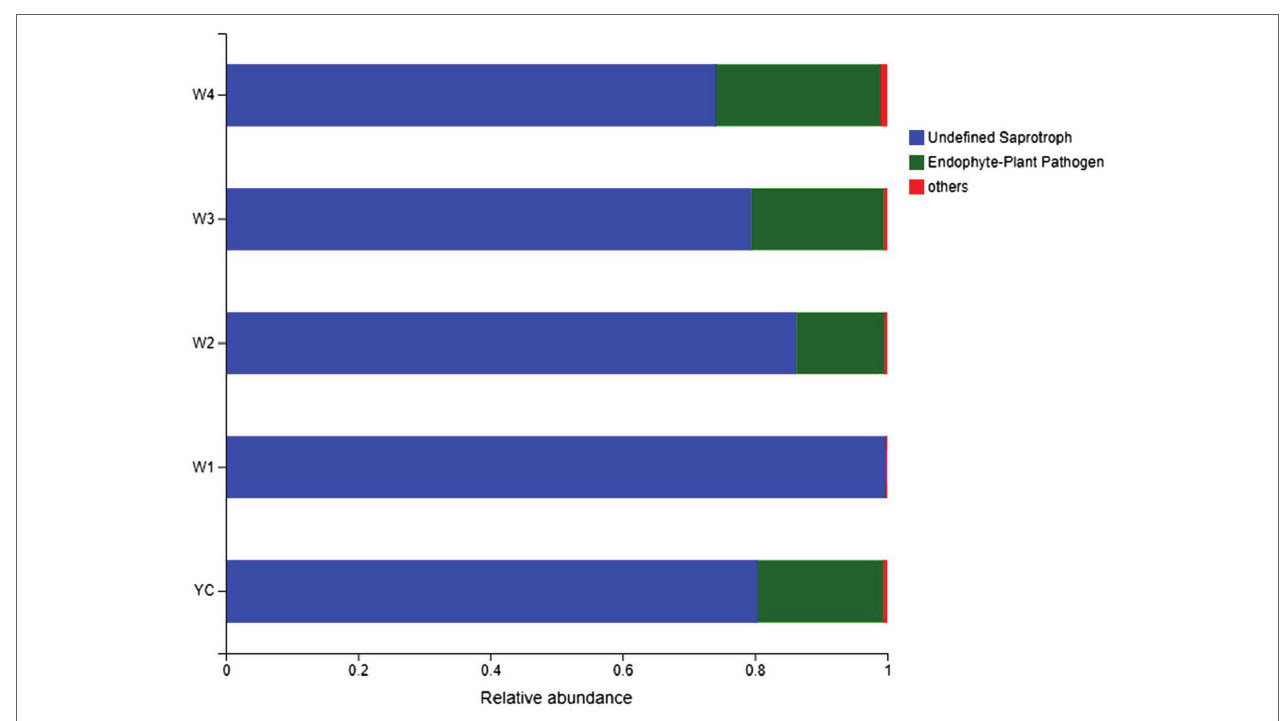
FIGURE 7 | FUNGuild analysis of fungal functional groups. The relative abundance of the Guild in different groups or samples is on the x -axis, and groups or samples are on the y -axis. According to the variation in functional groups, FUNGuild can calculate the abundance of each fungal species and their functional classification in each